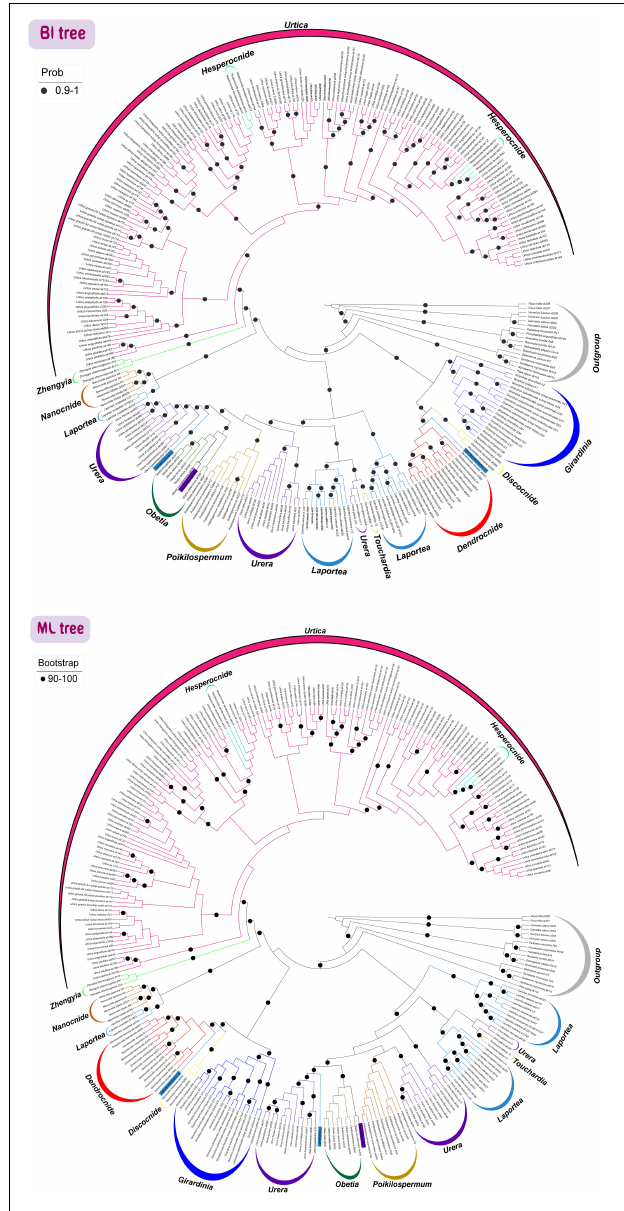
FIGURE 6 | Phylogenetic relationships of Urticeae tribe inferred from maximum likelihood (ML) and Bayesian inference (BI) based on trnL-F intergenic spacer and ITS ( trnL-F + ITS) loci sequences. Support values indicated by black circle show ML_BS ≥ 90 and BI_PP ≥